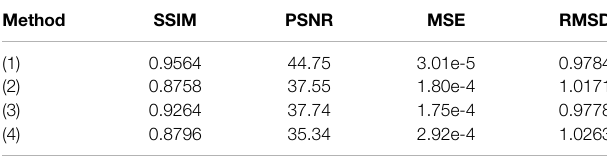
TABLE 10 | All the metric values of the recovered stress maps in Figure 11